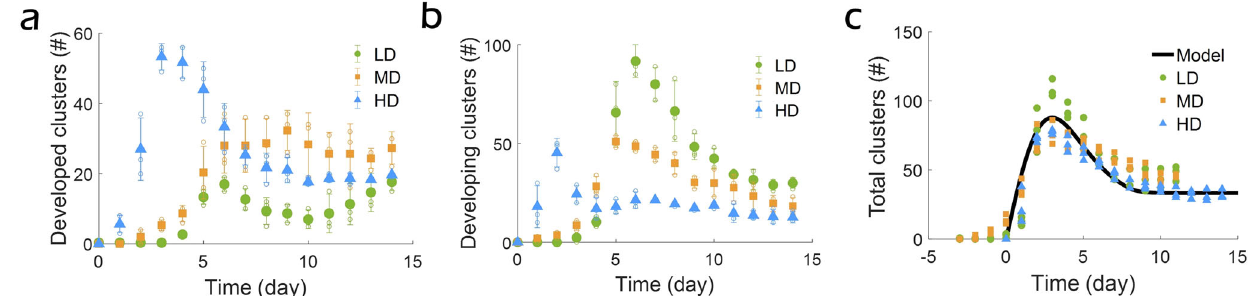
Fig. 5 Dynamics of cluster evolution. a Time evolution of the number of developed clusters for the different cell seeding densities. The maximum number of developed clusters is reached at days 14, 9 and 4 for the low (LD), medium (MD), and high (HD) seeding densities, respectively. b Time evolution of the number of developing clusters for the different cell seeding densities. The maximum number of developing clusters is reached at days 6, 5 and 2 for the low (LD), medium (MD), and high (HD) seeding densities, respectively. a , b Mean± SEM, N = 3. c Time evolution of total number of clusters (sum of developed and developing clusters) and physical model fi t. Three experiments for each density are